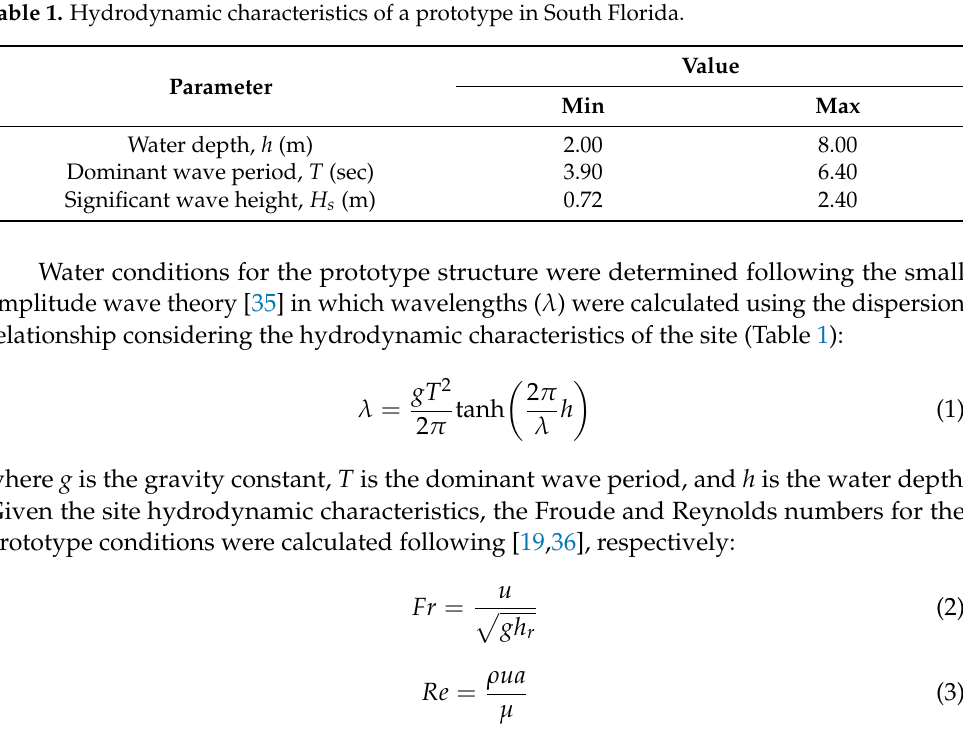
Figure 3. Illustration of the experimental setup (WW: wave wire, UDM: ultrasonic distance meter). Illustration not in scale. Wave conditions for the experiment were defined based on Froude similarity between prototype site characteristics and the reef model as the dominant forces are wind-generated gravity waves. Table 1 shows the hydrodynamic parameters considered for a prototype site in South Florida. Wave characteristics were determined from data taken from the Satan Shoal Buoy [34]. The data were averaged monthly for the period of 2019 to 2020 in order to determine the significant wave height and dominant wave period ranges. Table 1. Hydrodynamic characteristics of a prototype in South